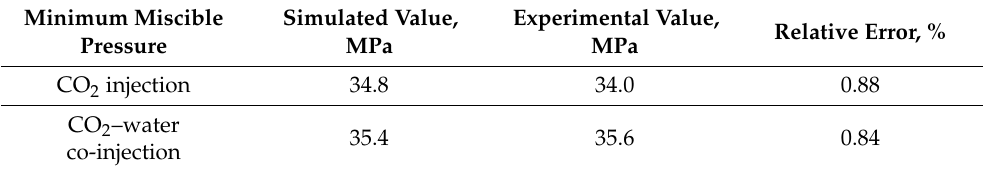
Table 10. Minimum Miscible Pressure under different injection methods (CO 2 to water injection ratio of